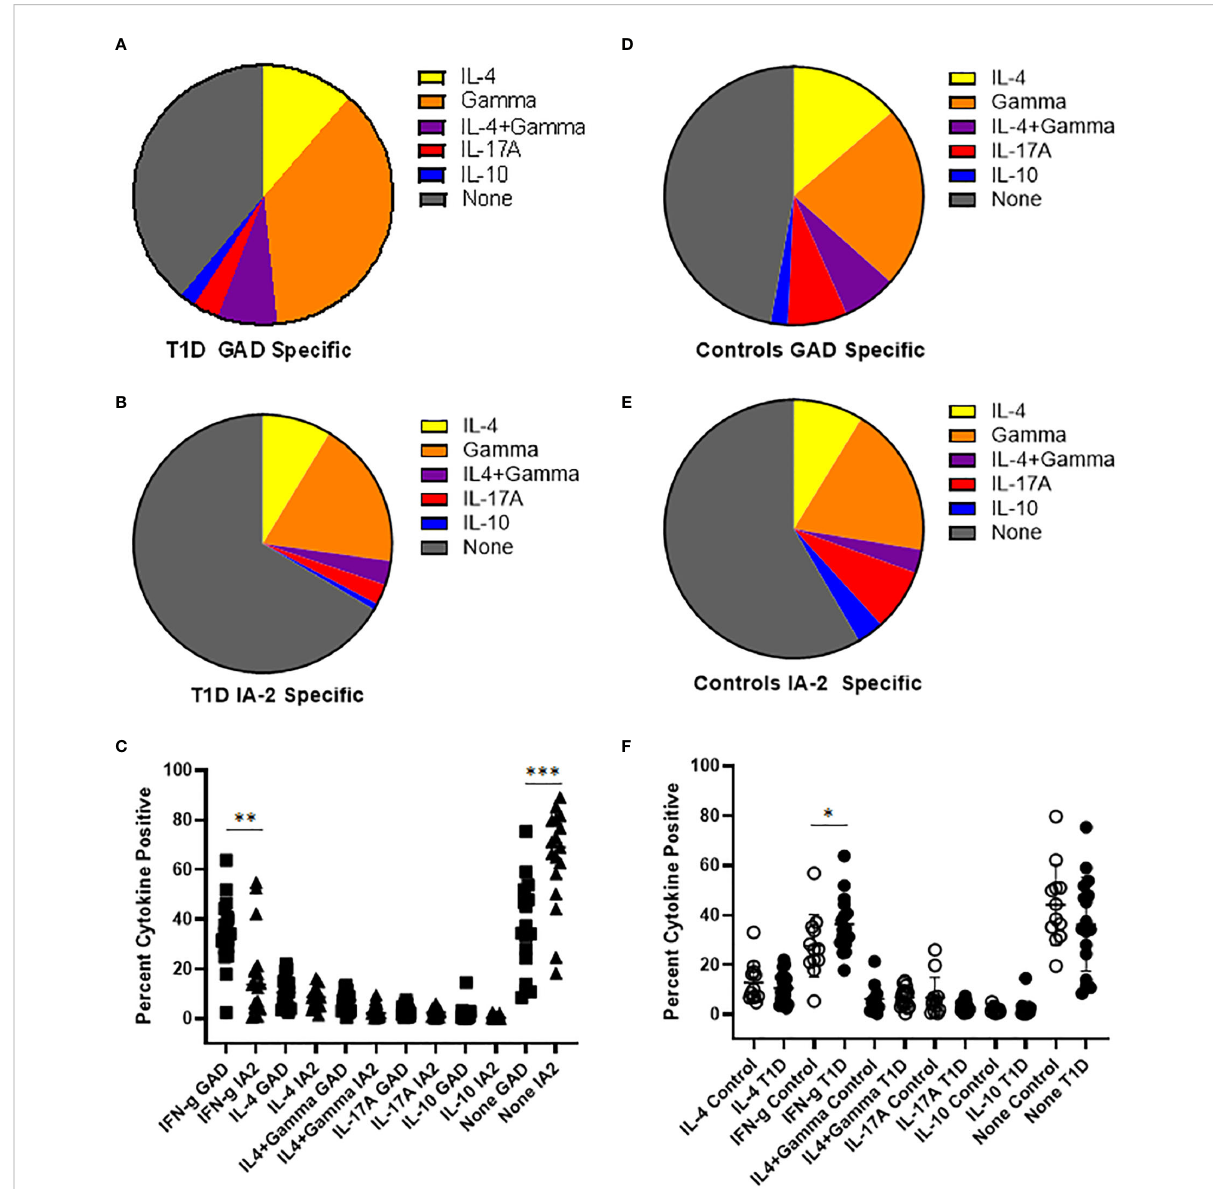
FIGURE 2 PTM GAD epitope speci fi c T cells have a distinct cytokine pro fi le in subjects with T1D. PTM GAD and IA-2 epitope speci fi c T cells were characterized by intracellular cytokine staining after a single round of in vitro expansion. (A) The cytokine pro fi les of PTM GAD speci fi c T cells were examined for 17 subjects with T1D. Taking the average across all subjects, cells that produced interferon- g only were predominant (34.4%), followed by IL-4 only (10.7%), IL4+ interferon- g (6.9%), IL-17A (3.0%), and IL-10 (1.9%); a notable proportion were cytokine negative (36%). (B) The cytokine pro fi les of PTM IA-2 speci fi c T cells were examined in the same 17 subjects with T1D. Taking the average across all subjects, cells that produced interferon- g only were predominant (18%) followed by IL-4 only (8.4%), IL4+ interferon- g (2.9%), IL-17A (2.5%), and IL-10 (0.8%); a major proportion were cytokine negative (65%). (C) Comparing PTM GAD (square symbols) and PTM IA-2 speci fi c T cells (triangles) in subjects with T1D, a signi fi cantly higher percentage of PTM GAD speci fi c T cells produced interferon- g only (p=0.0033, Mann Whitney test) and a signi fi cantly lower percentage were cytokine negative (p=0.0003). (D) The cytokine pro fi les of PTM GAD speci fi c T cells were also examined in 12 control subjects. Taking the average across all subjects, cells that produced interferon- g only were predominant (21.4%) followed by IL-4 only (12.9%), IL-17A (7.0%), IL4+ interferon- g (6.3%), and IL-10 (2.0%); a major proportion were cytokine negative (44%). (E) The cytokine pro fi les of PTM IA-2 speci fi c T cells were examined in the same 12 control subjects. Taking the average across all subjects, cells that produced interferon- g only were predominant (18.3%) followed by IL-4 only (8.5%), IL-17A (7.5%), IL-10 (3.3%), and IL4+ interferon- g (2.9%); a major proportion were cytokine negative (57%). (F) Comparing subjects with T1D ( fi lled circles) and controls (open circles), a signi fi cantly higher percentage of PTM GAD speci fi c T cells produced interferon- g only (p=0.05, Mann Whitney test). No other difference was signi fi cant. Horizontal lines in each panel indicate the mean value for each group. Vertical lines indicate standard deviations. * indicates p-value below 0.05 but above 0.01 ** indicates p- value below 0.01 but above 0.001 *** indicates p-value below 0.001 but above